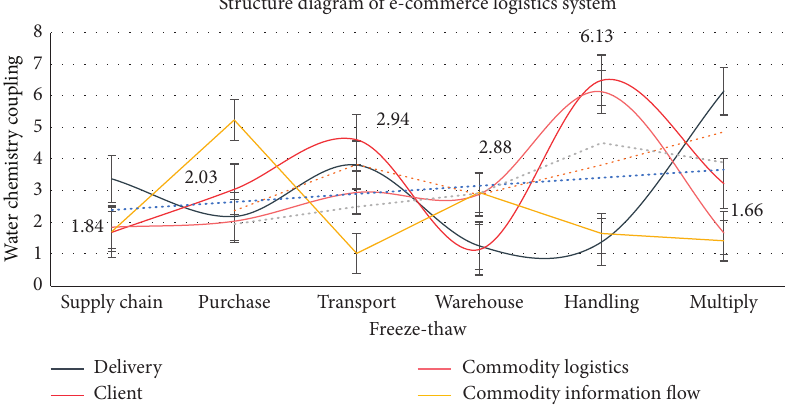
Figure 3: Structure diagram of e-commerce logistics Table 2: Main factors considered by online shoppers when buying unfamiliar products.